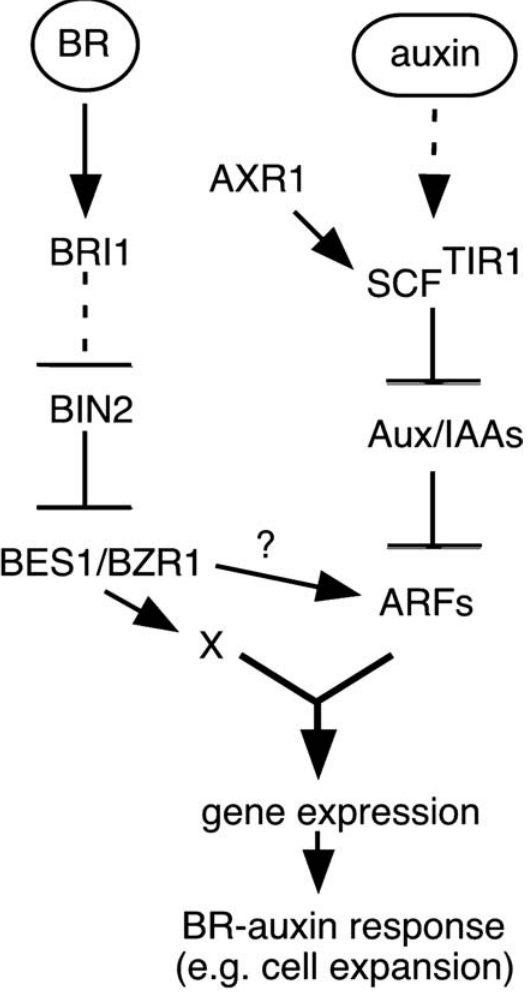
Figure 5. A Model of BR–Auxin